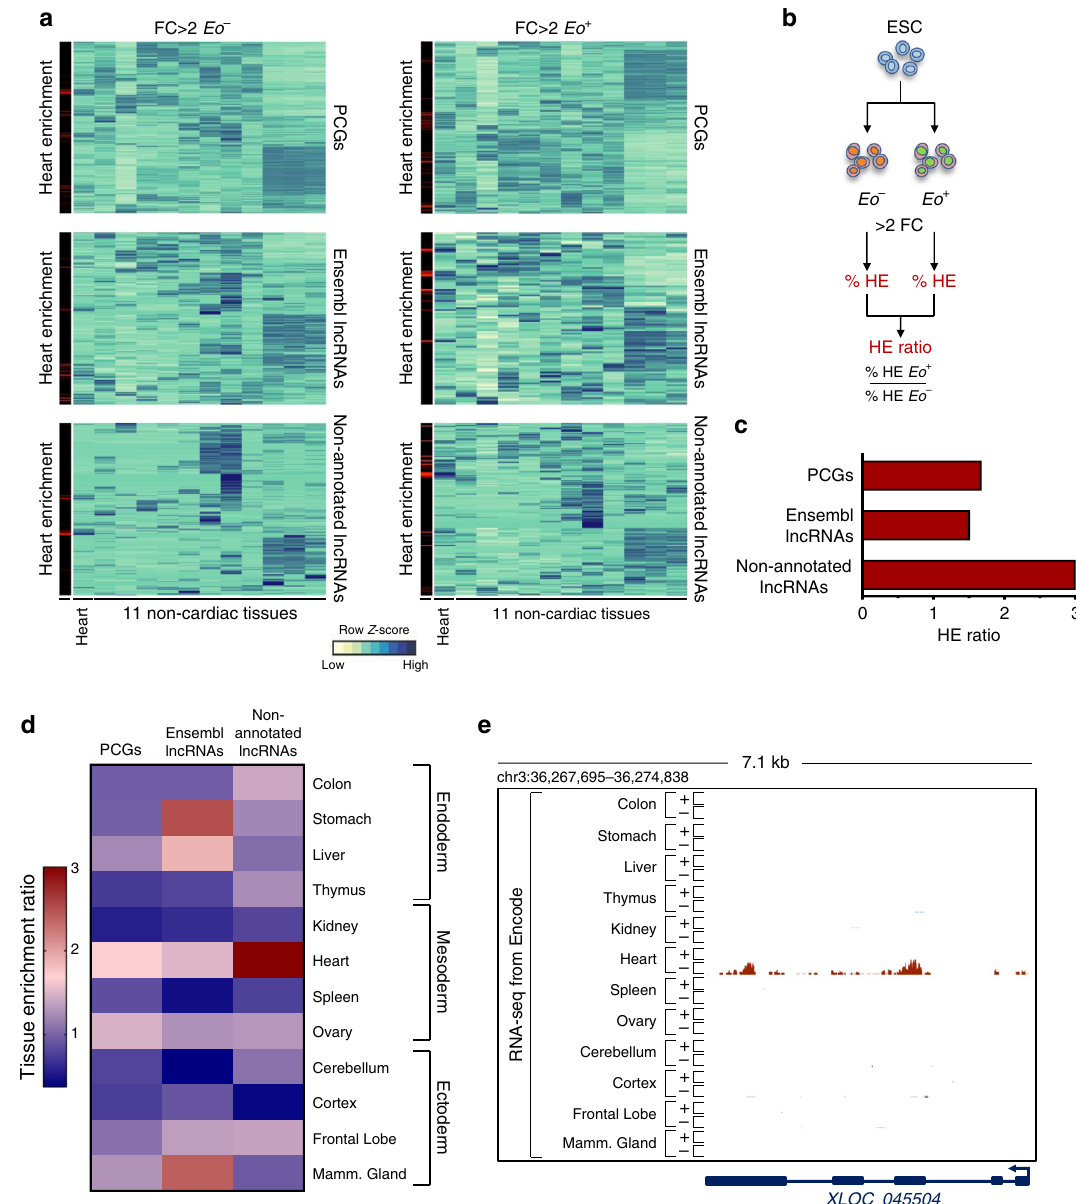
Fig. 2 Non-annotated lncRNAs have unique tissue enrichment characteristics. a Clustering of Eo − and Eo + enriched PCGs, Ensembl lncRNAs and non- annotated lncRNAs across adult heart and 11 non-cardiac mouse ENCODE tissues. Left-hand panels highlight individual heart-enriched transcripts in red. b Schematic illustration of the pipeline utilized to calculate the Heart Enrichment (HE) score. Eo − enriched transcripts ( > 2FC over Eo + ) and Eo + enriched transcripts ( > 2FC over Eo − ) were de fi ned. Percentage of heart enriched transcripts was de fi ned by comparing the expression of Eo − enriched transcripts and Eo + enriched transcripts in the adult heart vs. 11 non-cardiac tissues (The ENCODE Project Consortium, 2011). HE ratio was calculated by dividing the percentage of HE transcripts in Eo + over the percentage of HE transcripts in Eo − . c HE ratio in PCGs, Ensembl lncRNAs and non-annotated lncRNAs. d The same pipeline illustrated in ( b ) was applied to calculate tissue enrichment ratio for 12 mouse ENCODE tissues. Double gradient heatmap showing tissue enrichment ratio for the 12 mouse ENCODE tissues. e Strand-speci fi c RNAseq data from 12 ENCODE tissues is shown for an example non-annotated lncRNA enriched in Eo